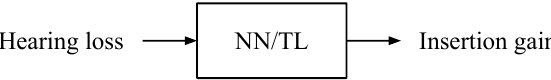
Figure 3. Block diagram of the proposed hearing-aid fitting.